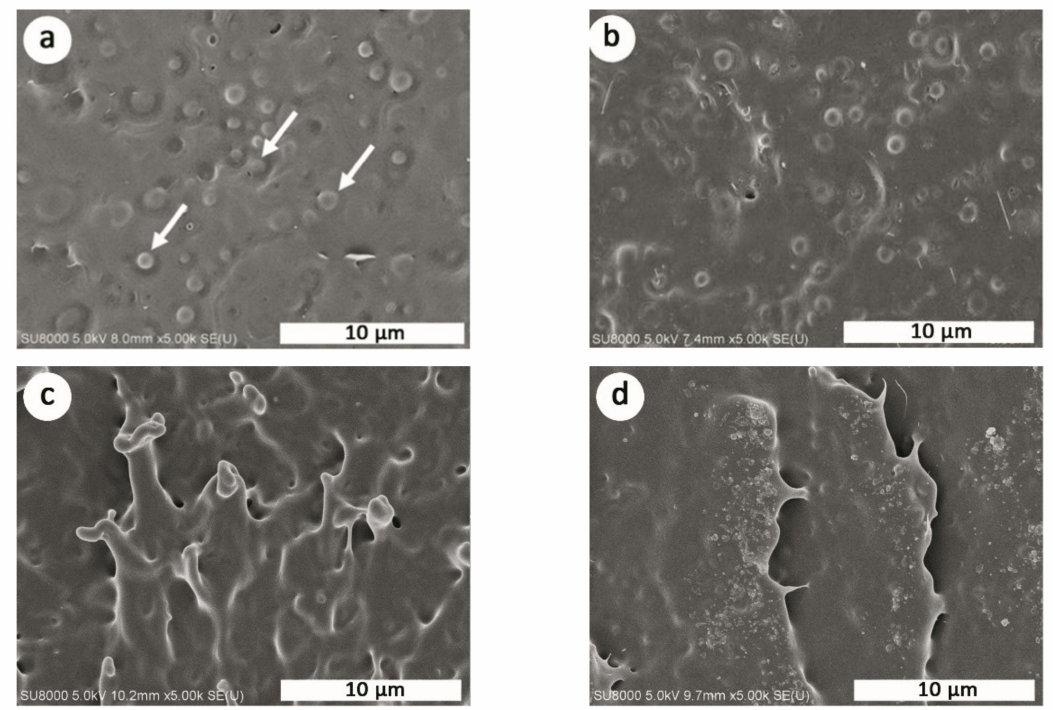
Figure 4. Cryogenic fractured surfaces of PLLA/PBS (80/20) blend ( a ) and plasticized blend ( b ), impact fractured surfaces of plasticized 80/20 blend annealed at 92 ◦ C for 10 min ( c ), and of the non-annealed counterpart ( d